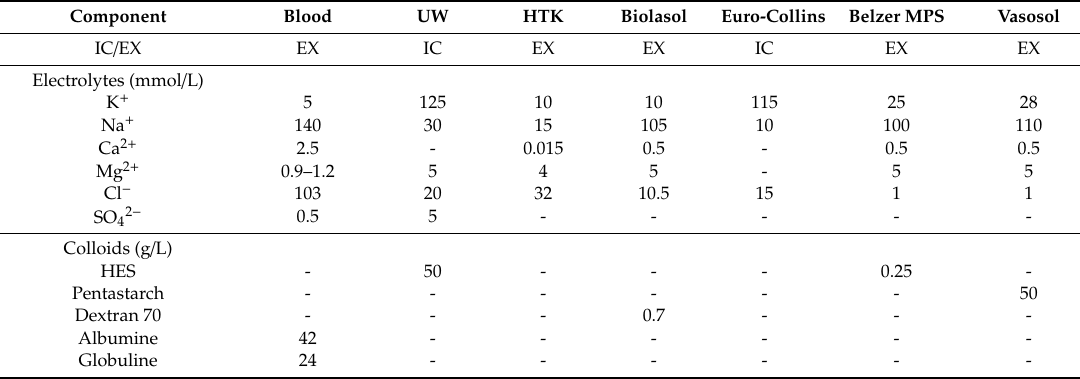
Table 1. Composition of preservation